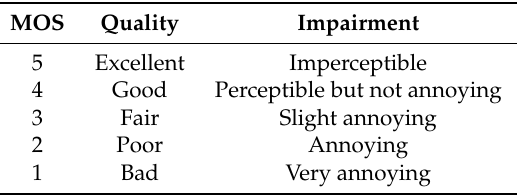
Table 2. Definitions of MOS [11].